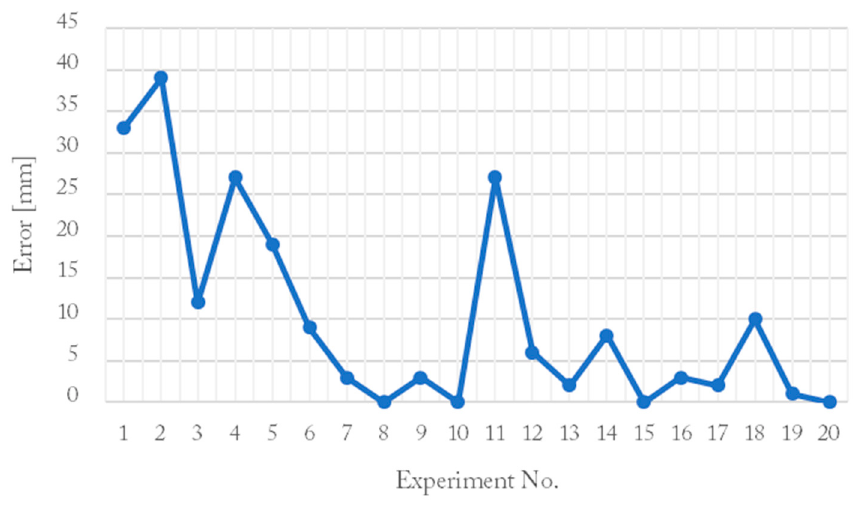
Figure 22. Field experiment results of distance compute algorithm.